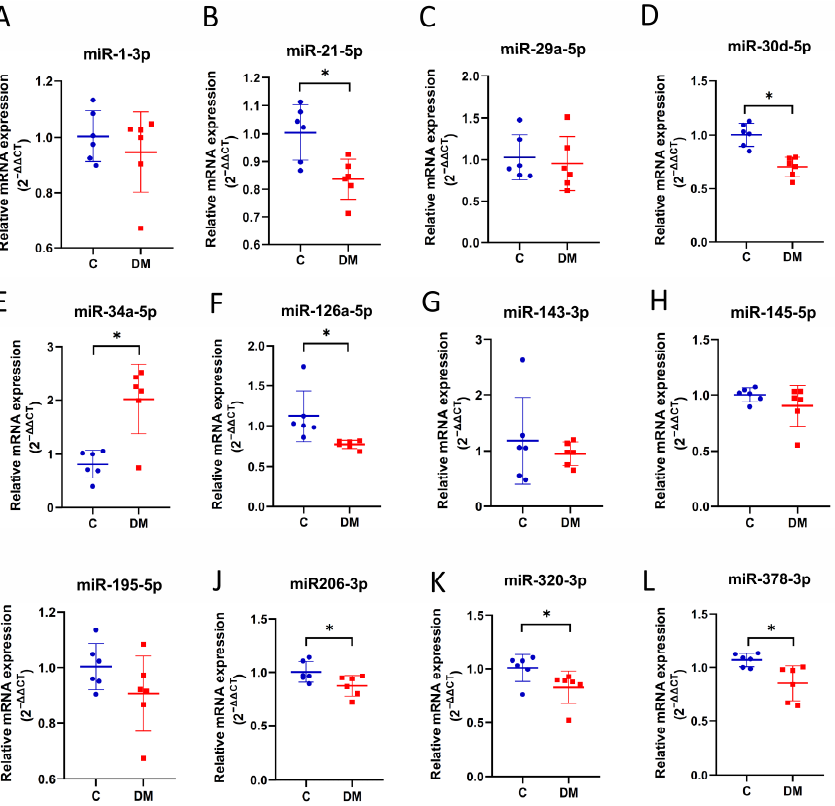
Figure 7. Expression of miRNAs in plasma EXO. The levels of miRNAs were examined using stem-loop RT-qPCR. ( A ) miR-1-3p. ( B ) miR-21-5p. ( C ) miR-29a-5p. ( D ) miR-30d-5p. ( E ) miR-34a-5p. ( F )